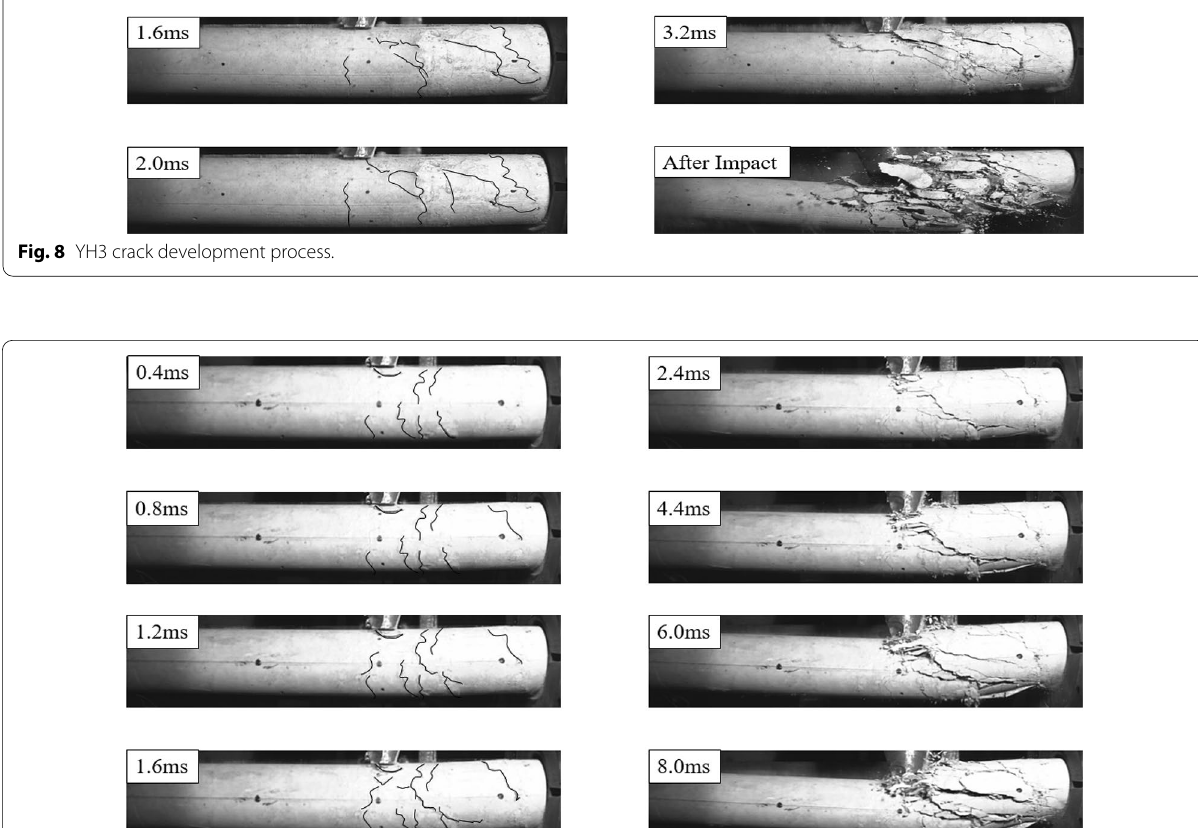
Fig. 9 YH4 crack development